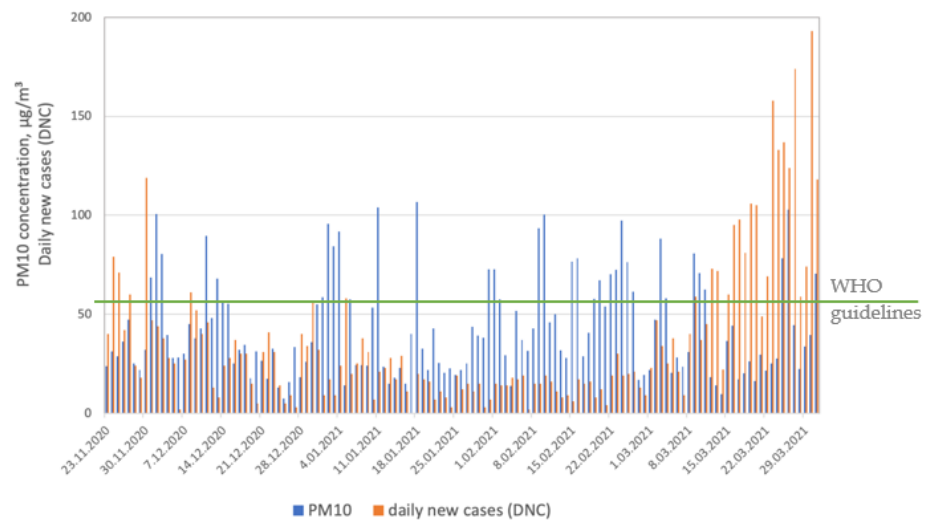
Figure 2. PM 10 concentrations and SARS-CoV-2 daily new cases (DNCs).